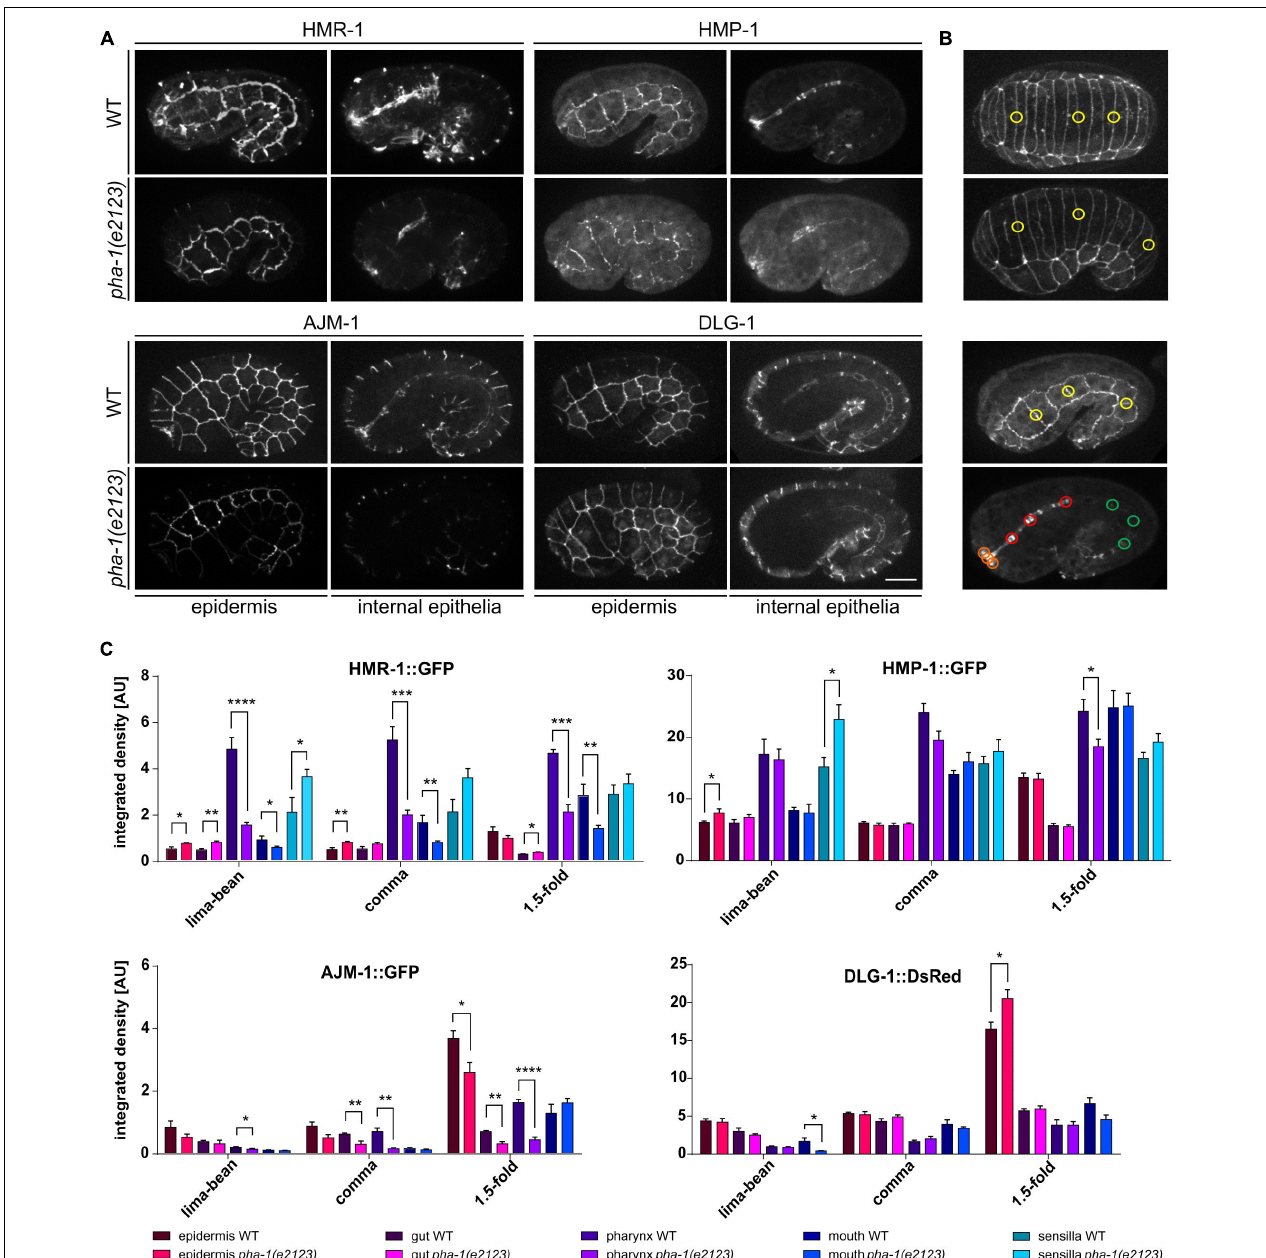
FIGURE 2 | pha-1(e2123) embryos show altered expression of CeAJ-components. (A) Maximum projections of WT and pha-1(e2123) embryos at 1.5-fold stage expressing HMR-1::GFP, HMP-1::GFP, AJM-1::GFP, and DLG-1::dsRed. Shown are the epidermis and internal epithelia (pharynx, gut, and mouth). Scale bar, 10 µ m. (B) Representative stages for measurements of signal intensities of CeAJ-components in C. elegans embryos (from top to bottom: lima-bean, comma, 1.5-fold epidermis, and internal epithelia). Colored circles mark areas used for measurements (yellow, epidermis; green, gut; red, pharynx; and orange, mouth). (C) Quantification of signal intensities of HMR-1::GFP, HMP-1:;GFP, AJM-1::GFP, and DLG-1::dsRed in different epithelia (epidermis, gut, pharynx, mouth, and amphid sensillae) of WT and pha-1(e2123) embryos (with SEM, n ≥ 4; * p < 0.05). Signals were measured during lima-bean, comma, and 1.5-fold stage. T-test: * p < 0.01; *** p < 0.001; and **** p <